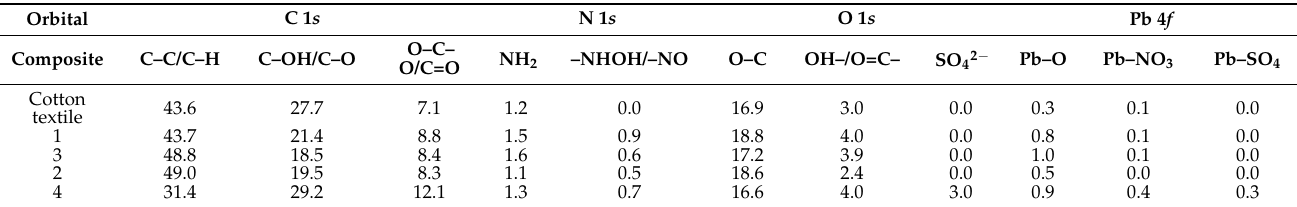
Figure 8. XPS high resolution spectra of core levels of C 1 s , N 1 s , O 1 s , and Pb 4 f for ( a ) cotton textile, ( b ) composite 1, ( c ) composite 3, ( d ) composite 2, and ( e ) composite 4. Table 3. Relative atomic concentration (%) for the different